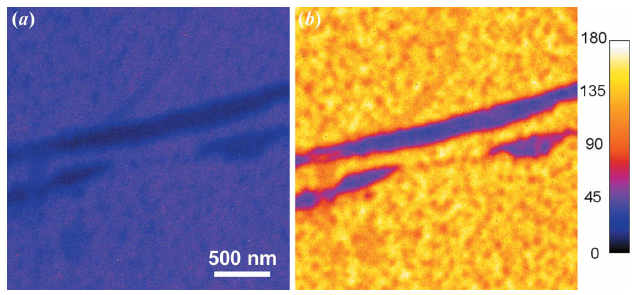
Figure 10 Si 2 p core-level XPEEM images taken in the ( a ) mirror-off and ( b ) mirror- on modes with both the SAA and the knife inserted. For better illustration, the original gray images were converted with a fake-color map. The average intensities of the two images are 34.7 and 120.8, respectively, as different CAs were used: 30 m m in ( a ) and 70 m m in ( b ). [Note that image ( b ) is a copy of the image in Fig. 9( h ).]